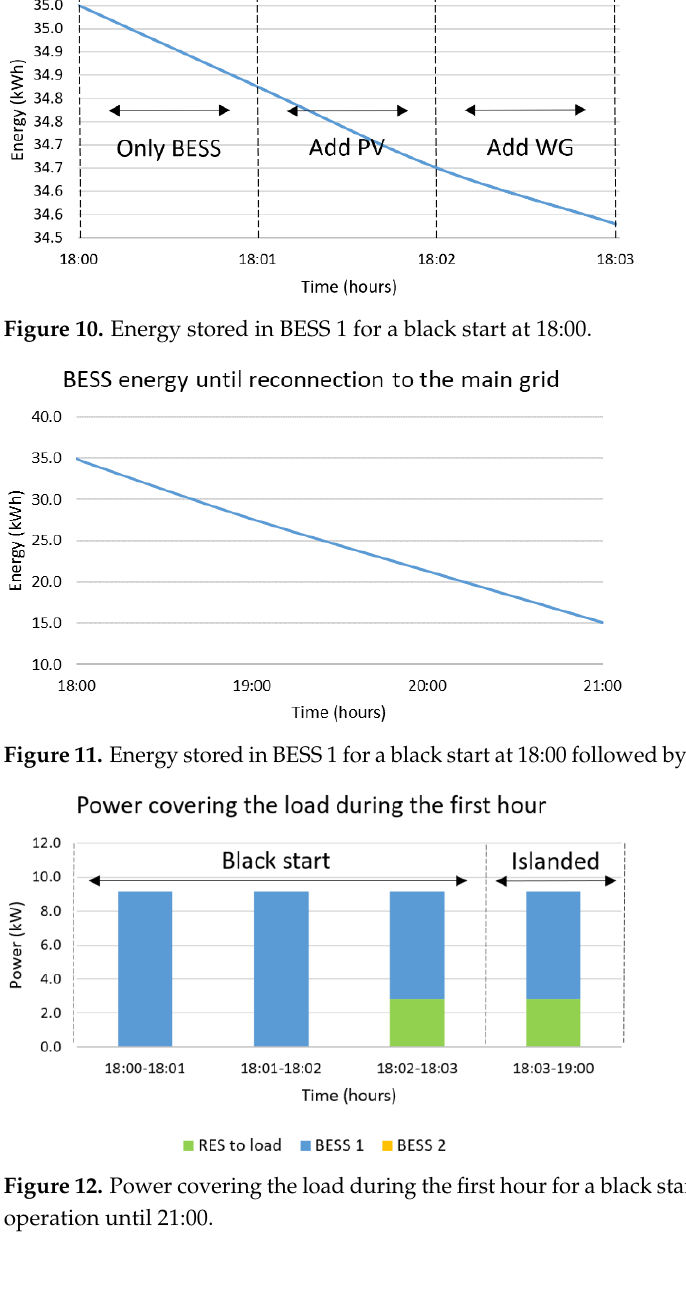
Figure 13 . Energy dispatch for a black start at 18:00 followed by islanded operation until 21:00. Table 3 . Main results from each simulated emergency case. Case 1